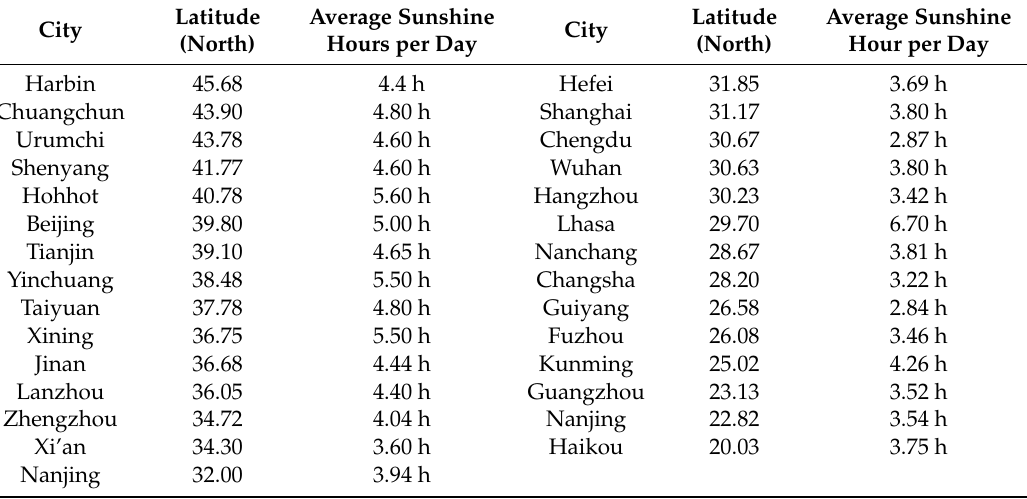
Table 1. Average sunshine hours per day in provincial capital cities in